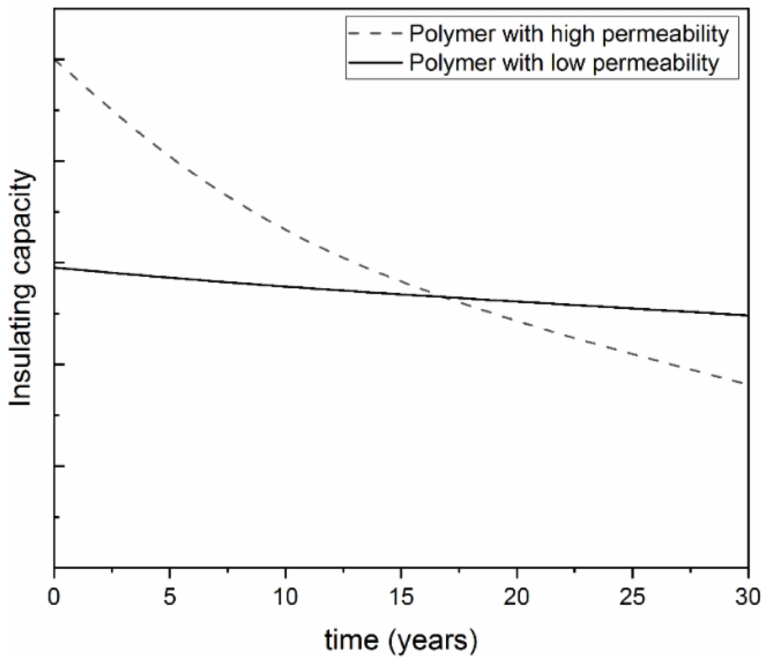
Figure 5. Conceptual representation of the long-term insulating capacity of foams depending on the permeability of the